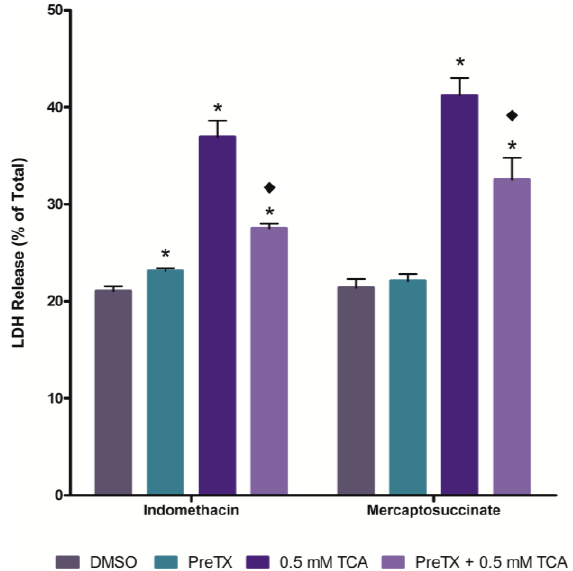
Figure 4. Effect of cyclooxygenase or peroxidase inhibition on TCA cytotoxicity at 120 min. An asterisk indicates significantly different from the DMSO control group value, p < 0.05. A diamond indicates significantly different from the 0.5 mM TCA alone value, p <